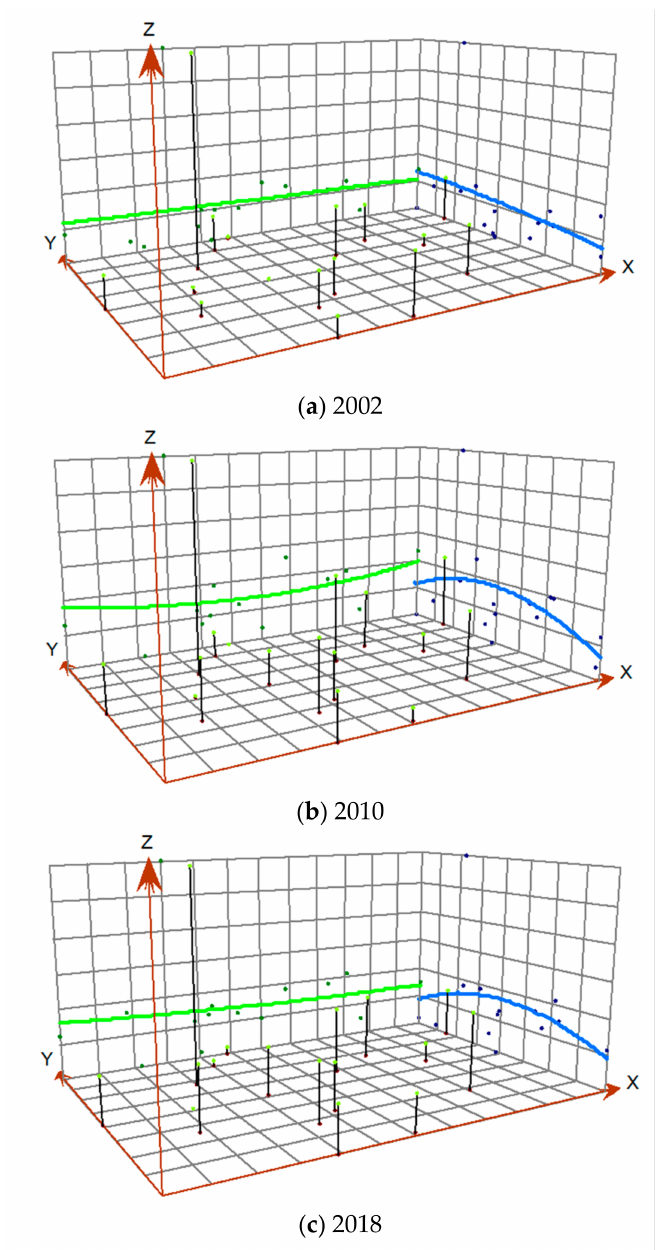
Figure 8. Evolution of deviation in the CCUA. Note: the locations of cities are plotted on the x , y axis. The height of a stick gives the deviation range index in the z dimension. Deviation range indexes are projected onto the x, z axis and the y, z axis as scatter plots. Polynomials are fit through the scatter plots on the projected axis. Polynomial curves in the x, z axis, and y, z axis show the deviation range in the east-west direction and north-south direction,